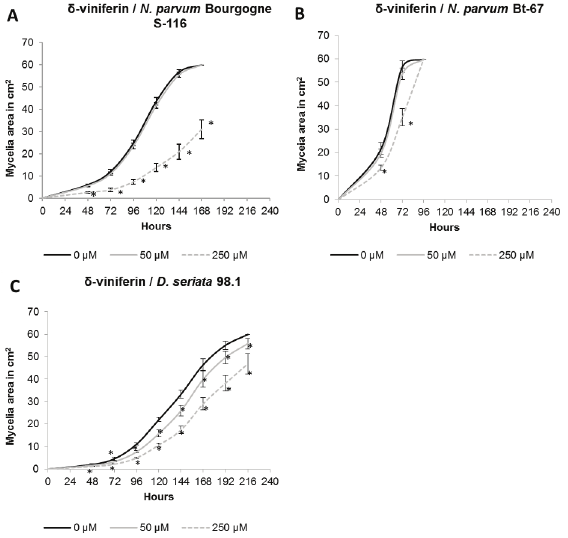
Fig 3. Effect of δ -viniferin on Botryosphaeriaceae . The δ -viniferin was tested at a final concentration of 50 μ M (grey lines) and 250 μ M (gray dotted lines) on N . parvum BourgogneS-116 (A), N . parvum Bt-67 (B) and D . seriata 98.1 (C) growth. δ -viniferinwas dissolvedin DMSO and negative control was performed by addingDMSO alone. Valuesare means and SD of two biologicalreplicates, each calculatedfrom the mean of three technicalreplicates. Means with a * are significantlydifferent from control at p (cid:20) 0.05 (Tukey Contrasts).